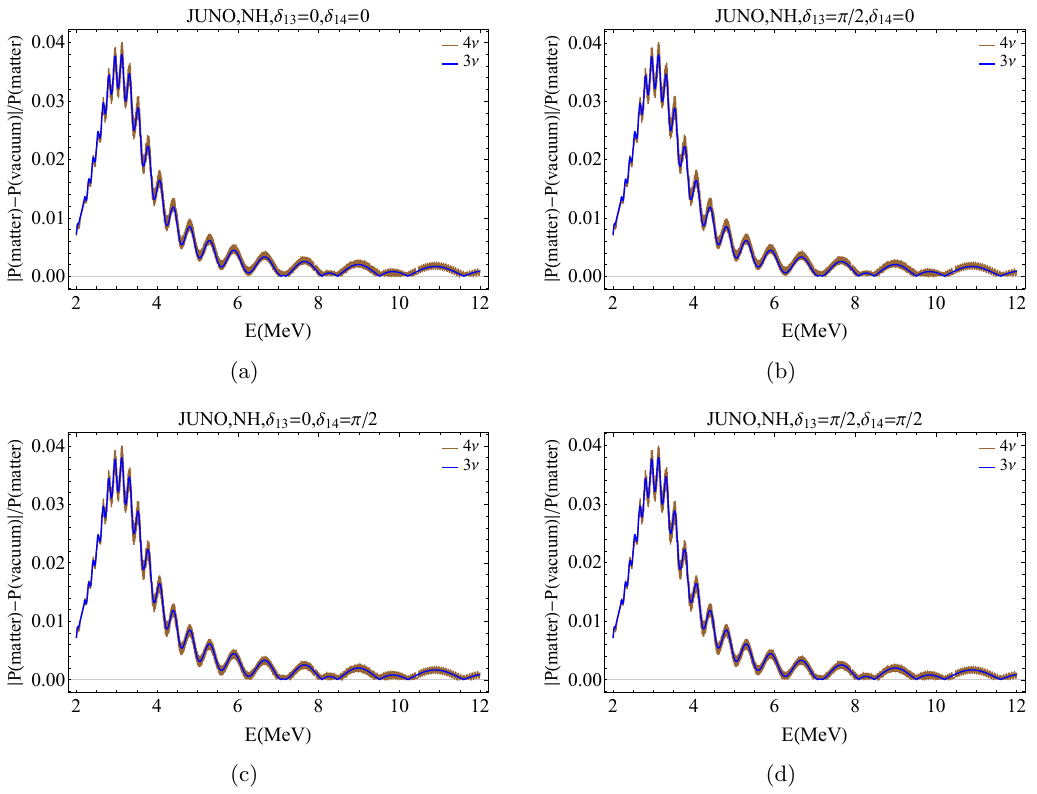
Figure 1 . Relative di(cid:11)erence for the (cid:22) (cid:23) e ! (cid:22) (cid:23) e in JUNO experiment, as a function of neutrino energy E in the scenarios of di(cid:11)erent CP phase combination, in which the brown line corresponds to the results in (3 + 1) scheme while the blue one correspond to the standard 3 (cid:23)